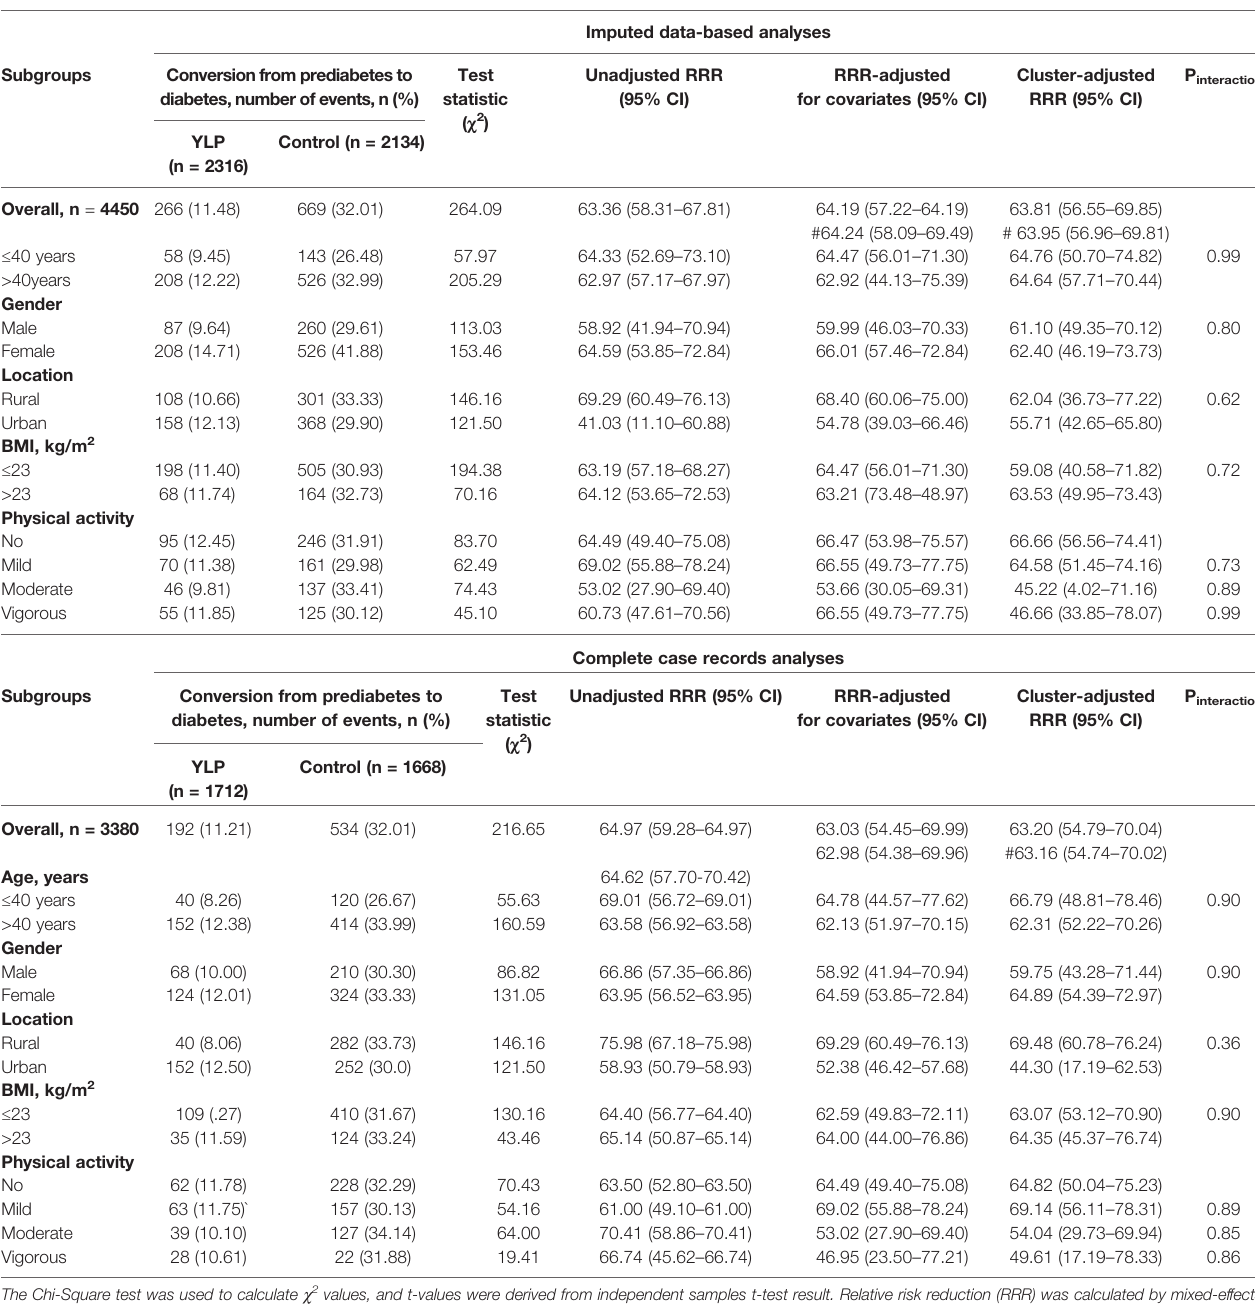
TABLE 2 | Effect of the YLP on the diabetes prevention at 3-month